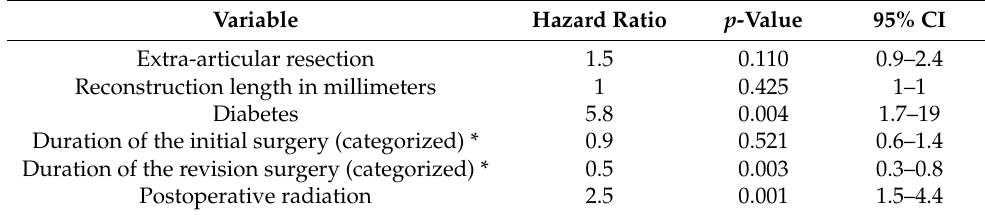
Table 5. Multivariate Cox regression analysis of risk factors for second prosthetic failure. * for the multivariate analysis the threshold value determined using Youden’s index was used as opposed to the metric value of the duration of